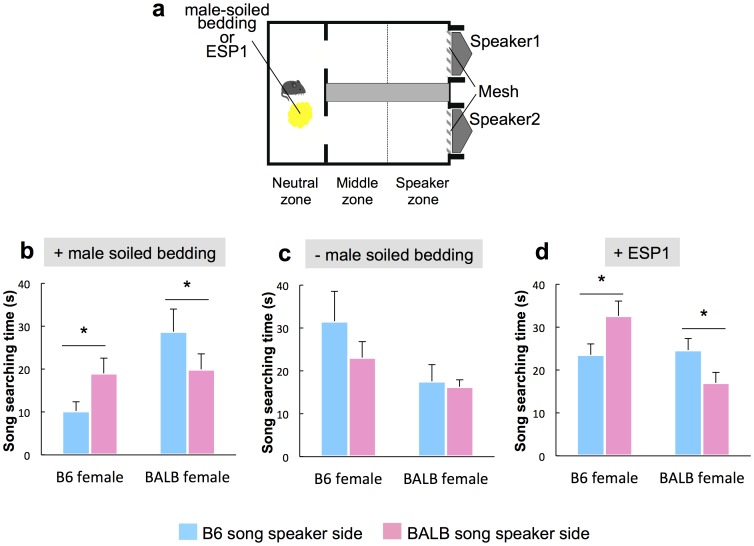
Female mice prefer songs of males from different strains.(a) Schematic of the apparatus used for the playback experiment. (b) B6 (n = 6) and BALB (n = 10) females in diestrus exposed to male-soiled bedding before testing showed longer-duration search times for other strains' songs. (c) Duration of time searching during diestrus in B6 (n = 5) and BALB (n = 7) females in the absence of male odor before testing. (d) B6 (n = 11) and BALB (n = 13) females in diestrus exposed to male pheromone ESP1 before testing showed longer duration search times for other strains' songs. Values represent means+standard error. Asterisks indicate significant differences p<0.05.